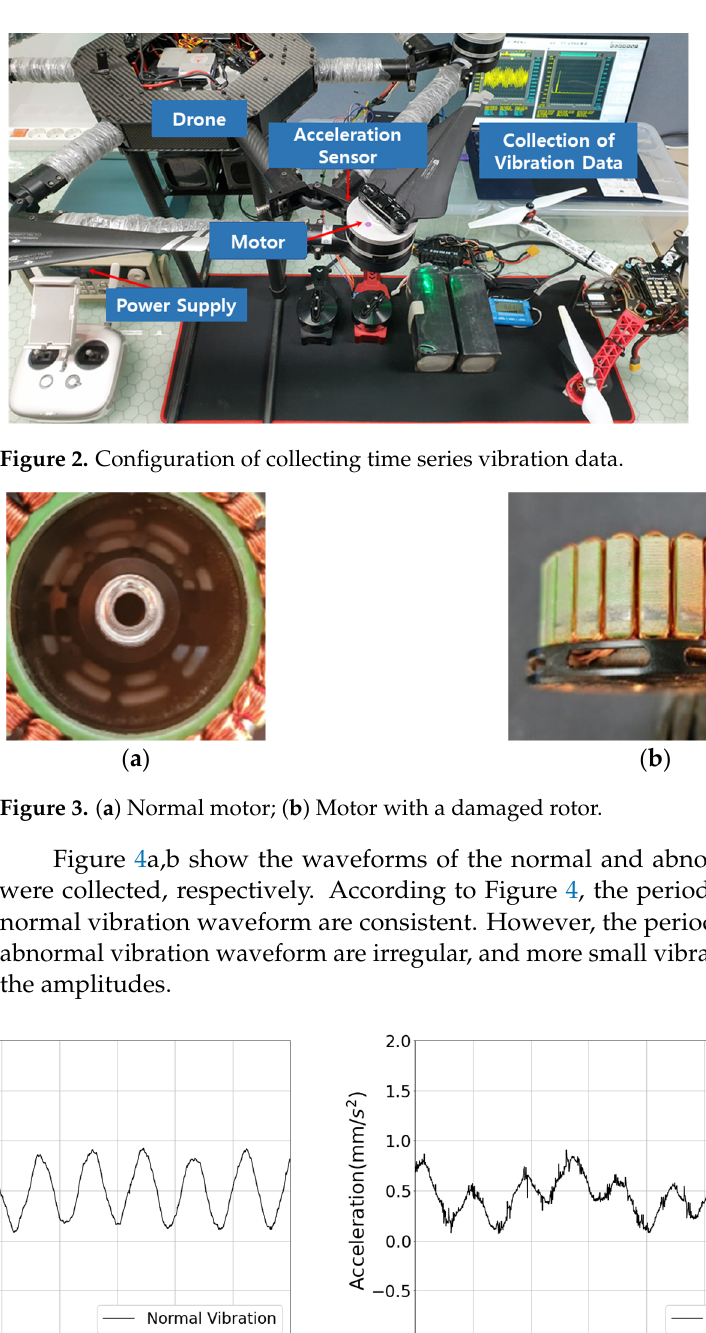
Figure 3. ( a ) Normal motor; ( b ) Motor with a damaged rotor. Figure 4. Waveform of the motor’s vibrations: ( a ) a normal motor; ( b ) an abnormal motor.